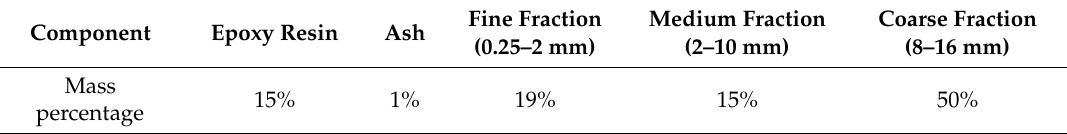
Table 1. Composition of the applied filling polymer